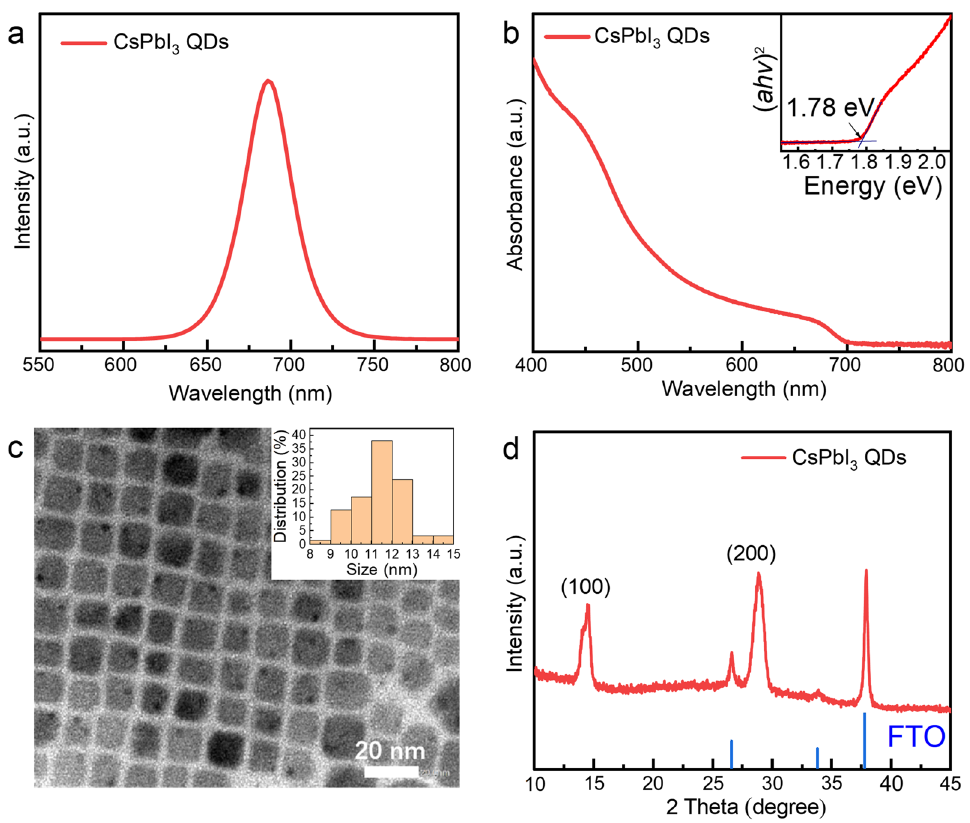
Fig. 2 a PL spectra of CsPbI image of CsPbI